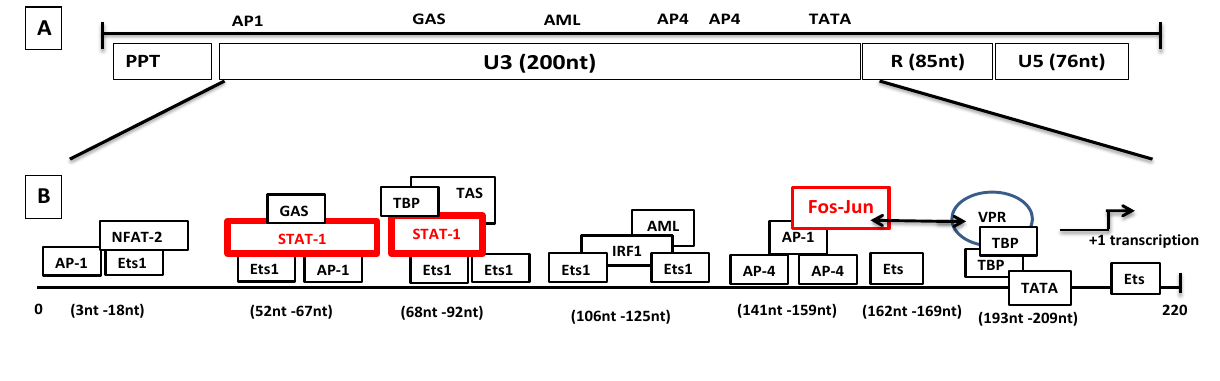
Figure 6. Genomic organization of SRLVs and mechanism of LTR transactivation independent of Tat. ( A ) Various regions of the SRLV LTR are